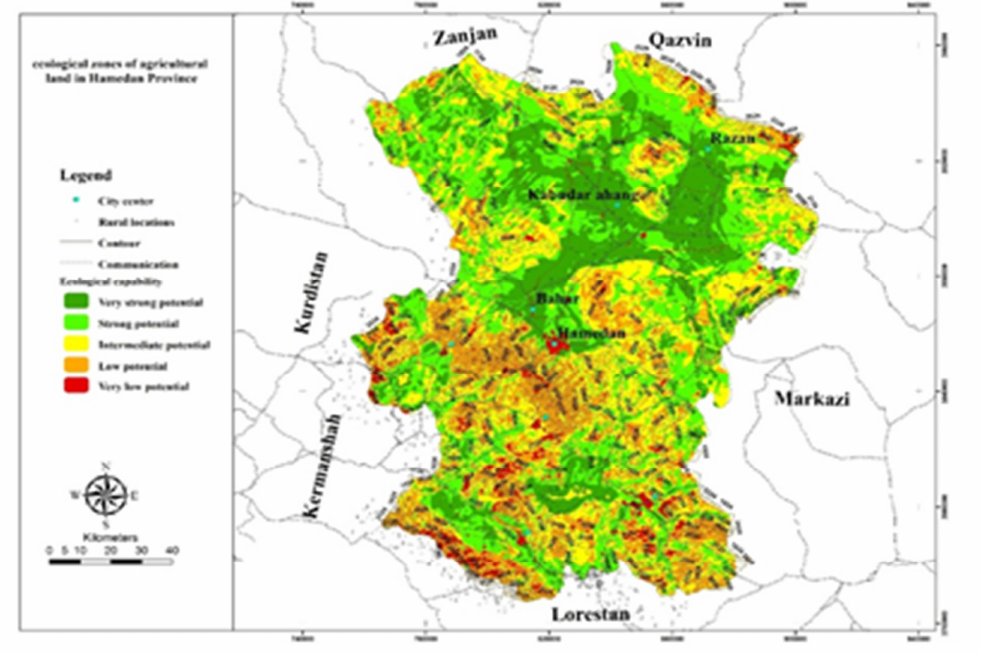
Figure 5. Ranking the ecological zones of agricultural land in the province of